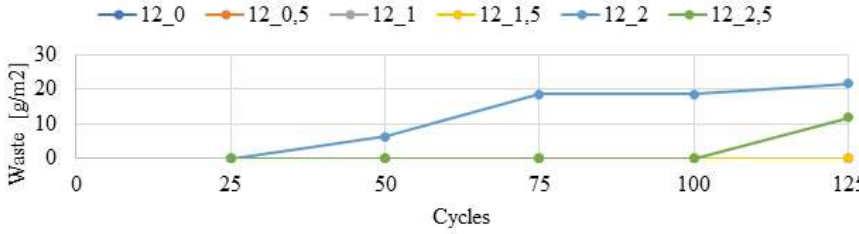
Figure 9. Series no. 12 - Results of the chemical thaw substances resistance tests.